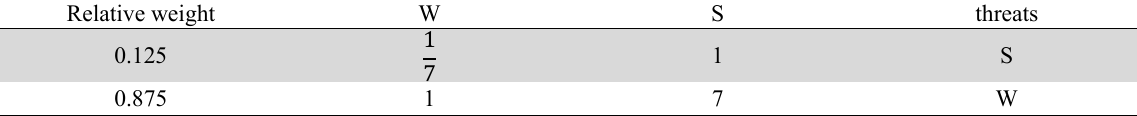
Interdependency matrix of SWOT factors given the